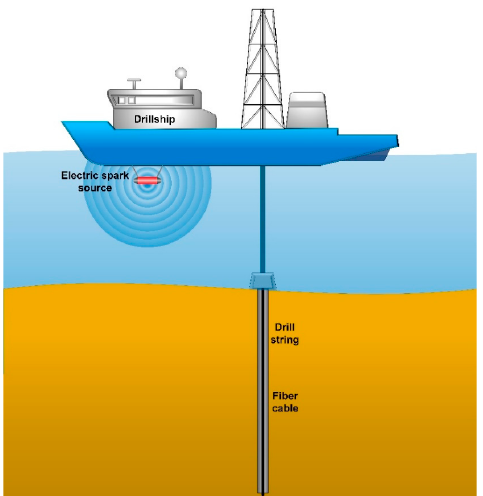
Figure 7. Zero-offset vertical seismic profiling (ZVSP) obtained in the Laptev Sea.